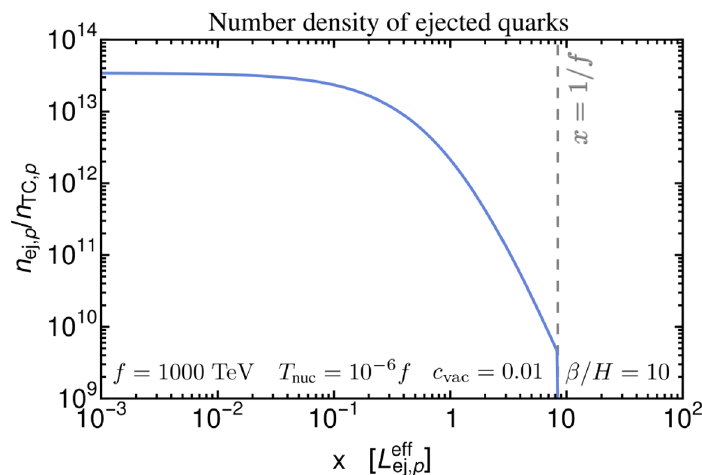
Figure 7 . The density of the ejected quarks in front of the bubble wall as a function of the distance x in front of the bubble wall, eq. (7.5), for an example parameter point. Here we have used the relation γ ’ DT nuc . The distance to the outermost techniquanta L ej,p ≈ 1 /f is also wp